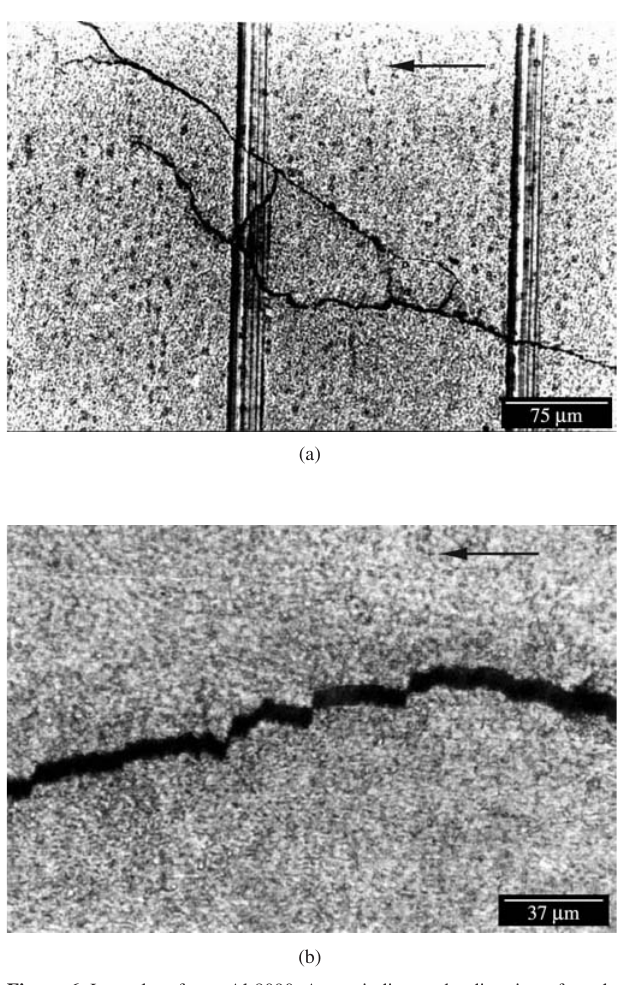
Figure 6. Lateral surfaces, Al 8090. Arrow indicates the direction of crack